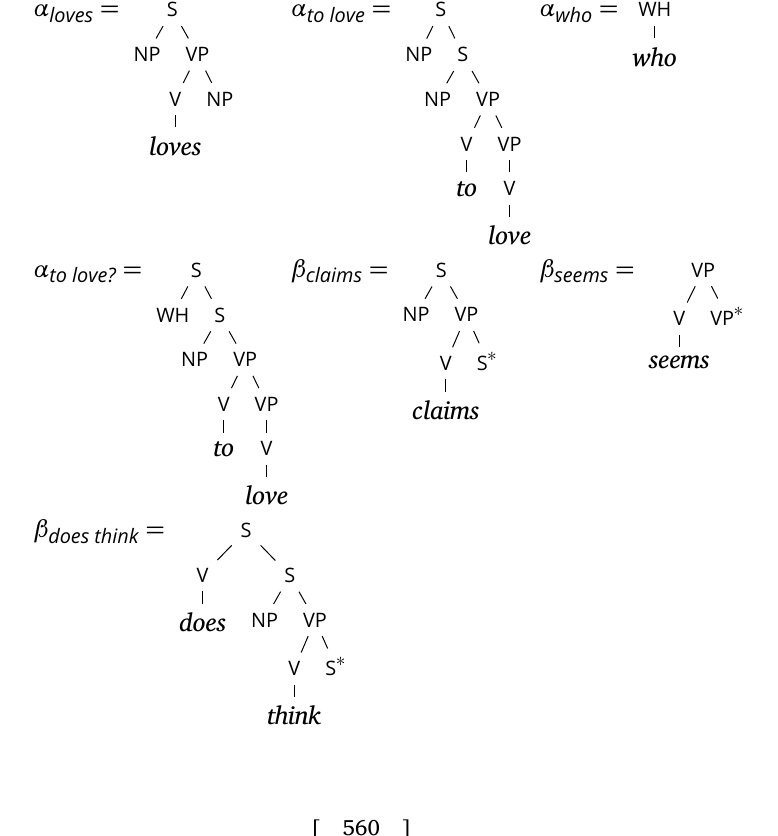
Figure 16: TAG elementary trees for long distance